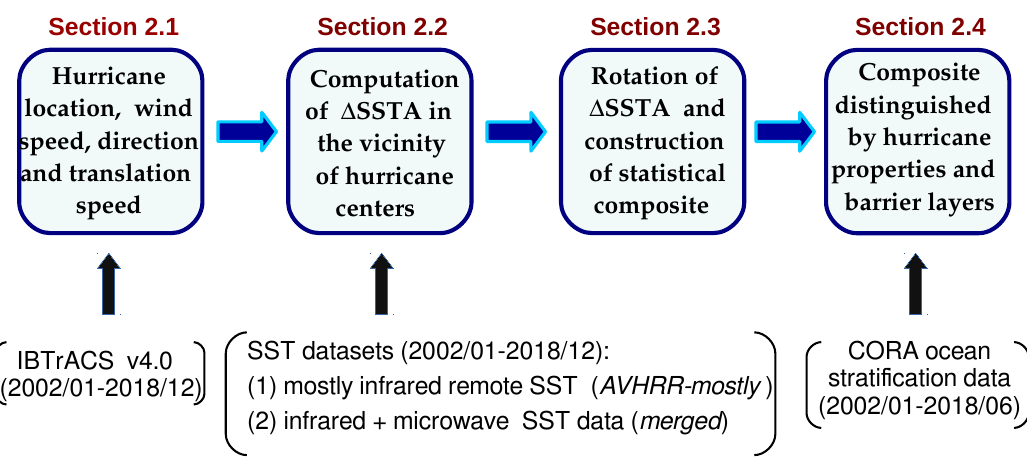
Figure 1. Flow chart summarizing data and methods of this work described in Section 2. SSTA are the SST anomalies after the linear trend and the seasonality have been removed. ∆ SSTA refers to the hurricane-induced cooling (cold wake). Years refer to the common period of all datasets used in this study